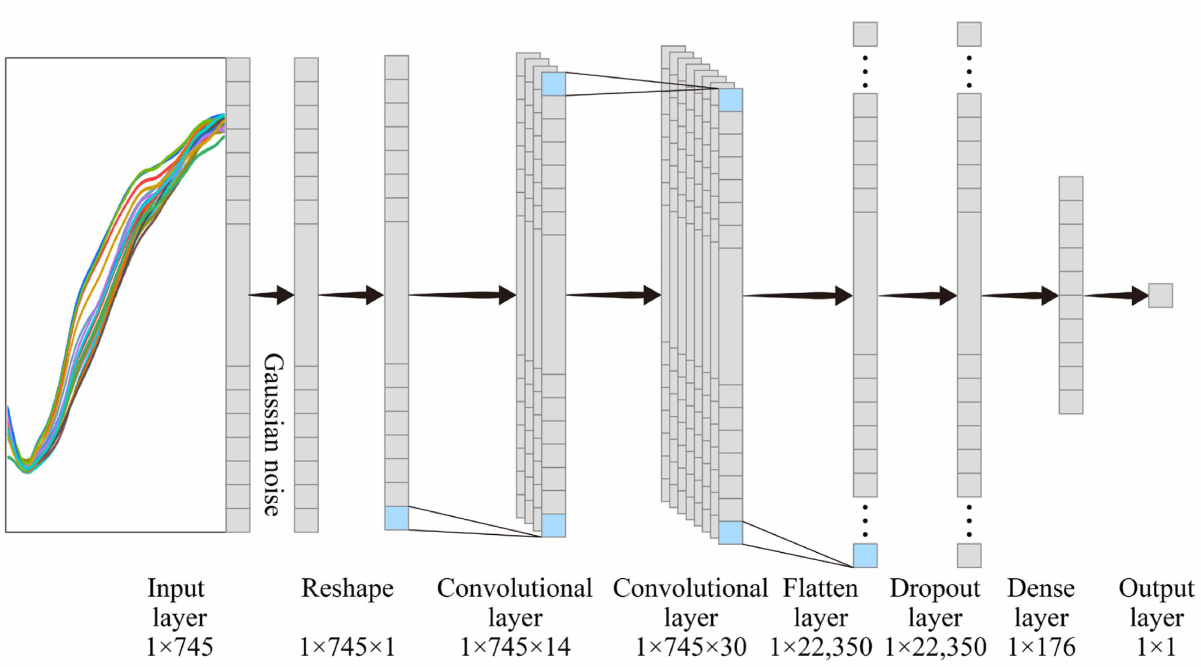
Figure 4. One-dimensional neural convolutional network